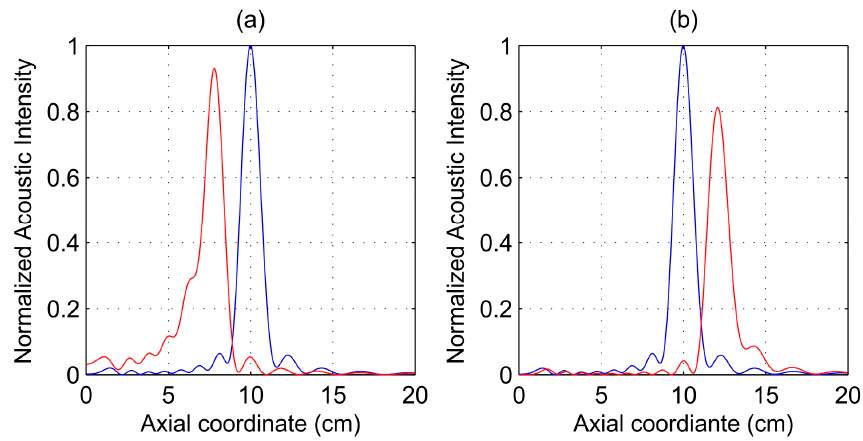
Figure 2. Simulated acoustic intensity against axial distance. Blue line: 250 kHz. Red line: ( a ) 220 kHz; ( b ) 280 kHz.